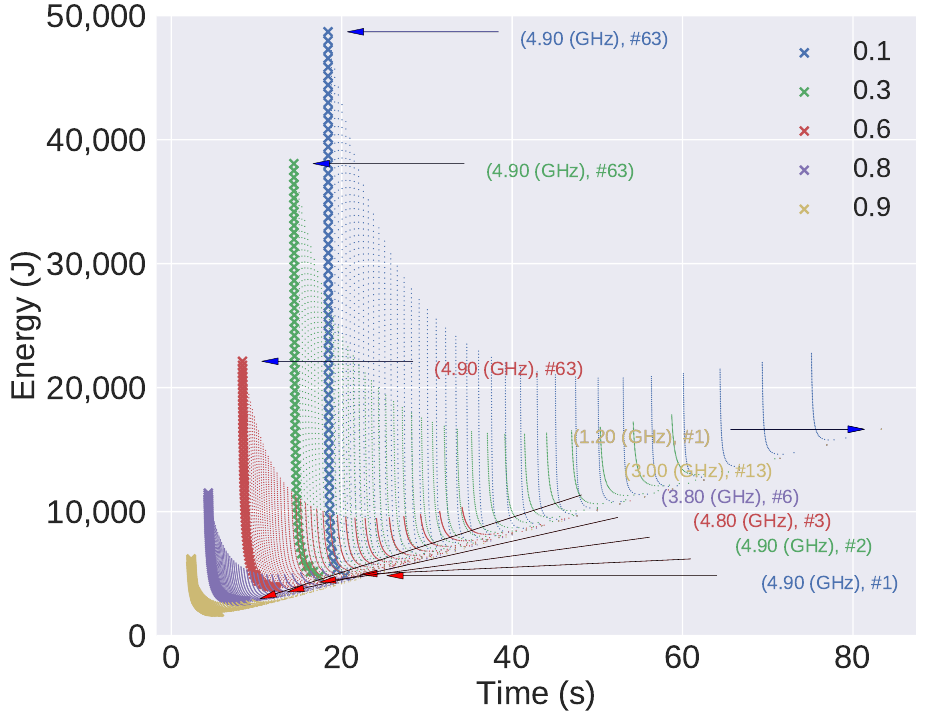
Figure 13. Pareto frontier for several values of static power parameter. The arrows with blue heads indicate the maximum energy, while the arrows with a red head, the minimal, for each corresponding